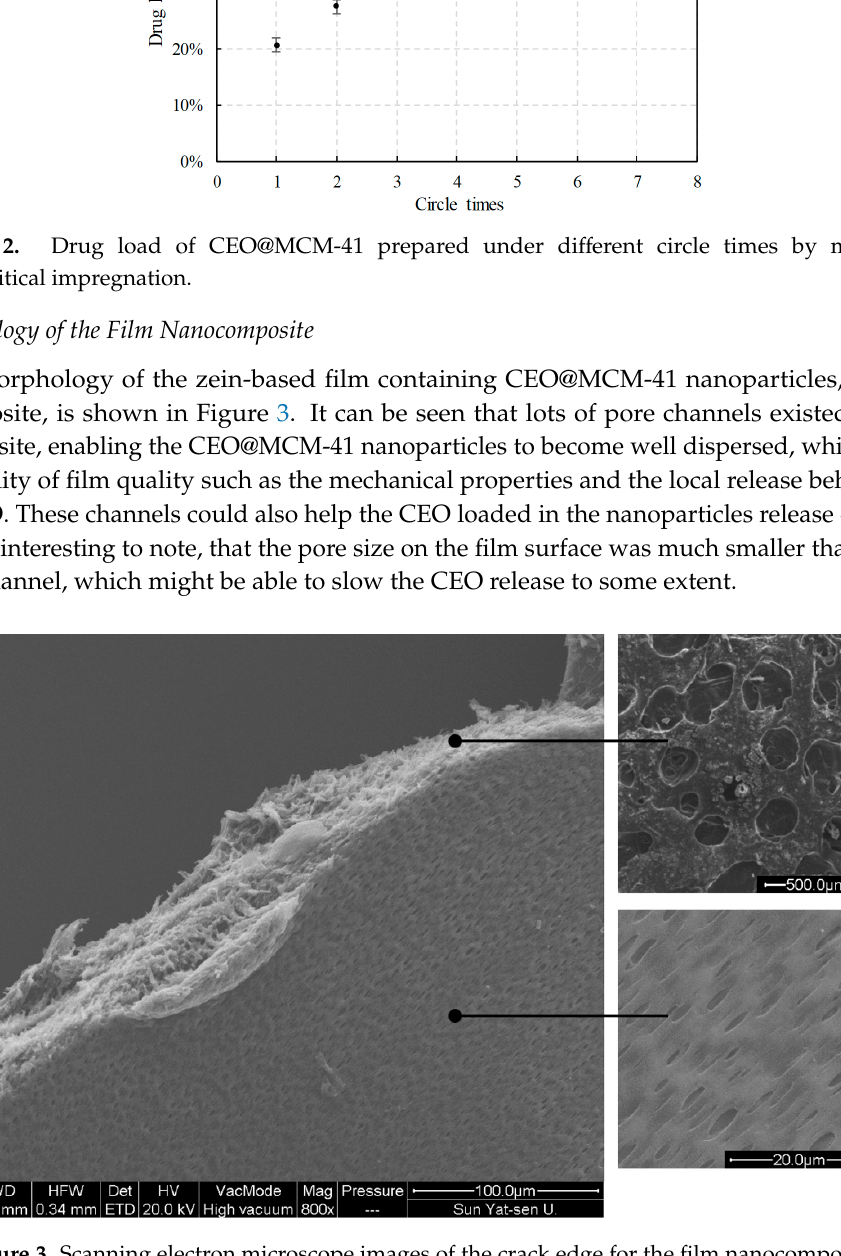
Figure 3. Scanning electron microscope images of the crack edge for the film nanocomposite.